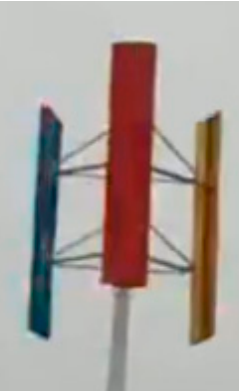
Figure 8. Typical Nano-crystalline PV panel.